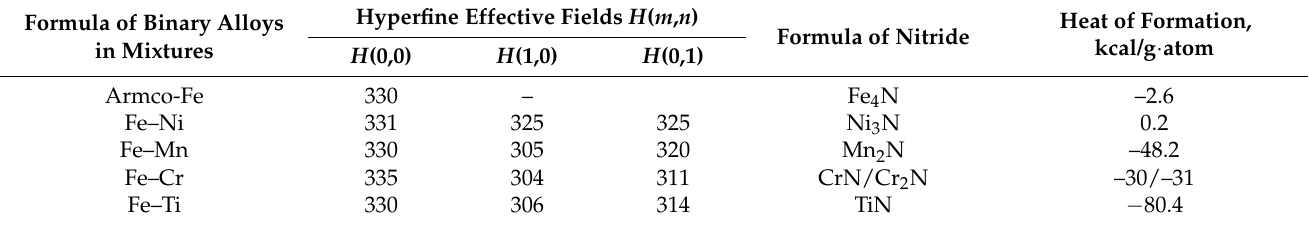
Table 2. Magnitudes of magnetic hyperfine fields in alloys [34] in the initial mixture and the heat of the formation of nitrides with the chemical elements of alloying at room temperature